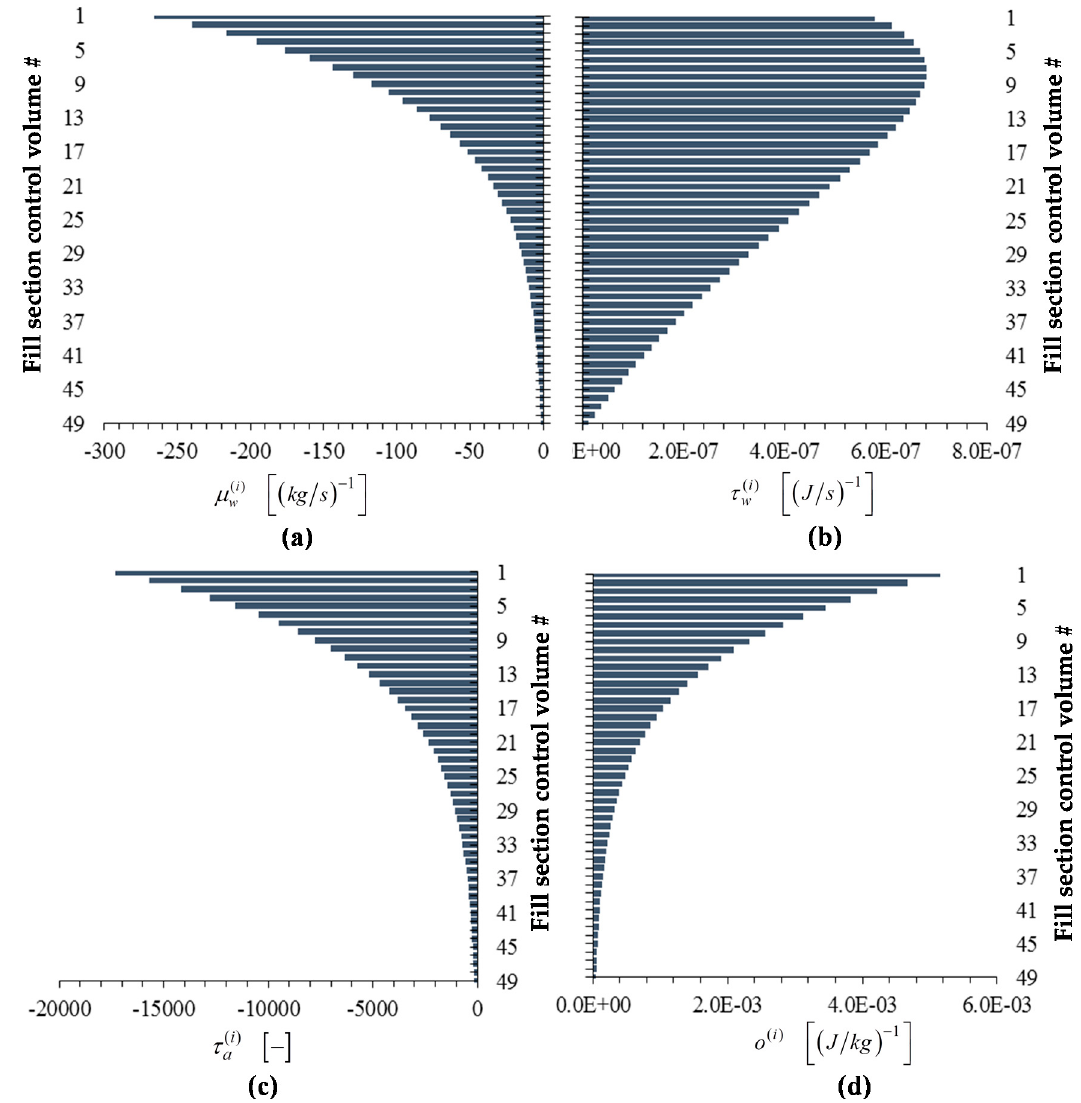
Figure 10. Bar plots of adjoint functions for the response R (cid:44) RH ( 1 ) as functions of the height of the cooling tower’s fill section: ( a ) µ w (cid:44) (cid:16) (cid:17) o ( 1 ) ,..., o ( 49 ) ( d ) o (cid:44) . For the response R (cid:44) RH ( 1 ) , the value of the adjoint function µ a is −